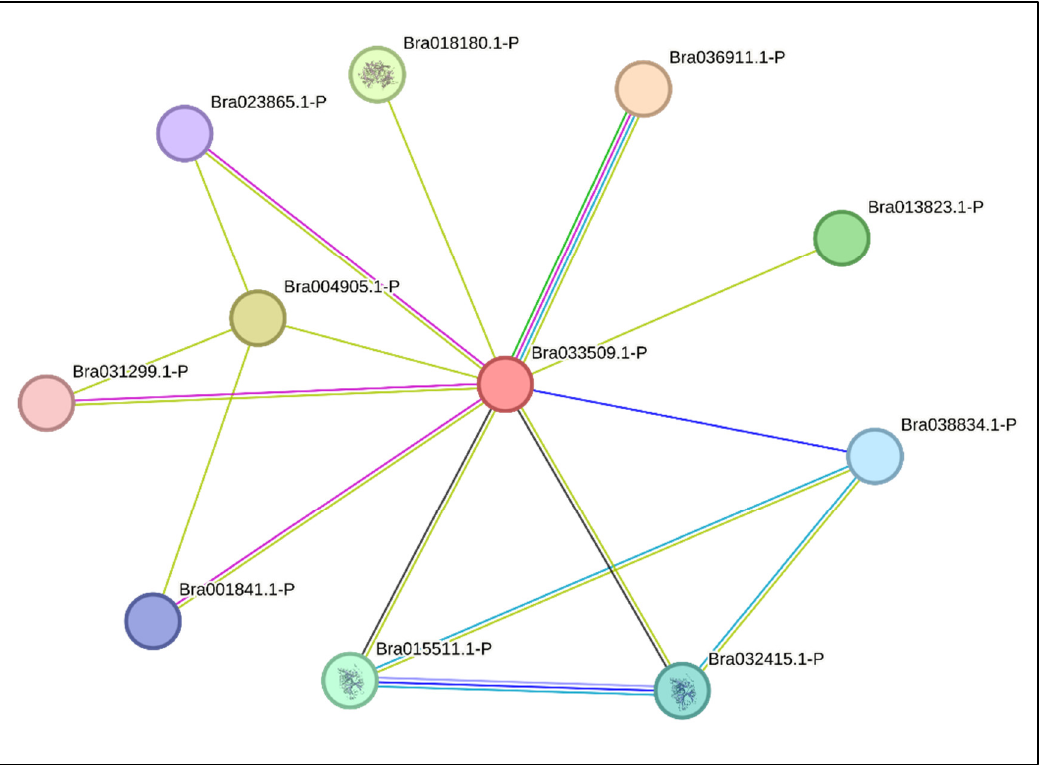
Figure 5. BrCYP71A15 protein–protein association network.